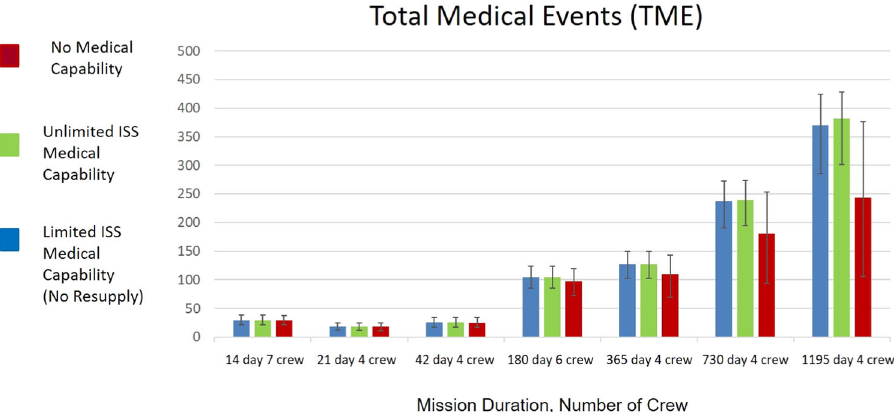
Fig. 2 Total medical events predicted for the indicated mission duration and crew complement. The results are shown by DRM across the x-axis and subdivided by the level of medical capability included in each situation. The 95% CIs is interpreted as the uncertainty estimated with respect to the data informing the 100 medical conditions and the PRA abstraction of the medical event timeline and end-states. As unaccounted uncertainties are not represented in this formulation or data representation, outcomes should be considered as representative of relative changes in risk rather than absolute risk assessments 14 . ISS International Space